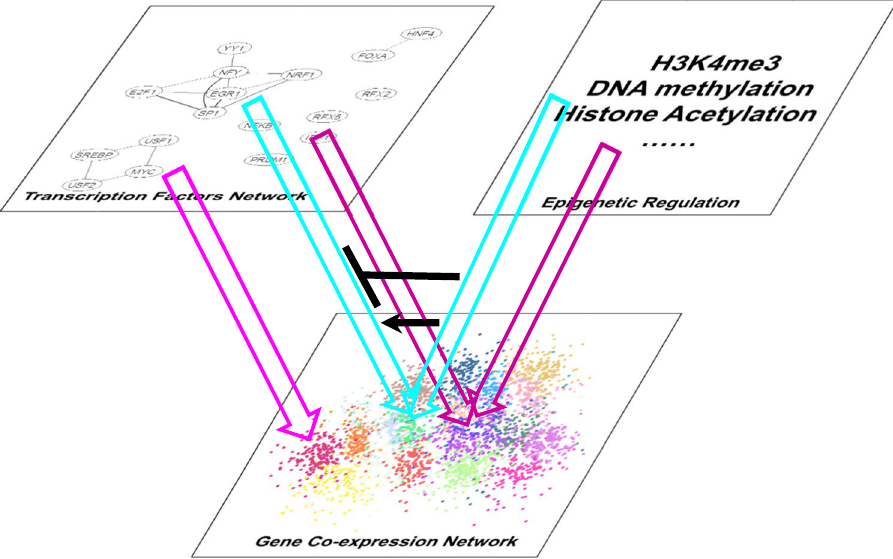
Figure 5. A gene regulatory system with different layers of regulations. The gene regulatory system consists of three layers: gene co-expression network, transcription factors network, and epigenetic regulation. Gene co- expression network capture the output of the regulatory system, i.e. the expression patterns, which are regulated by both transcription factors network and epigenetic